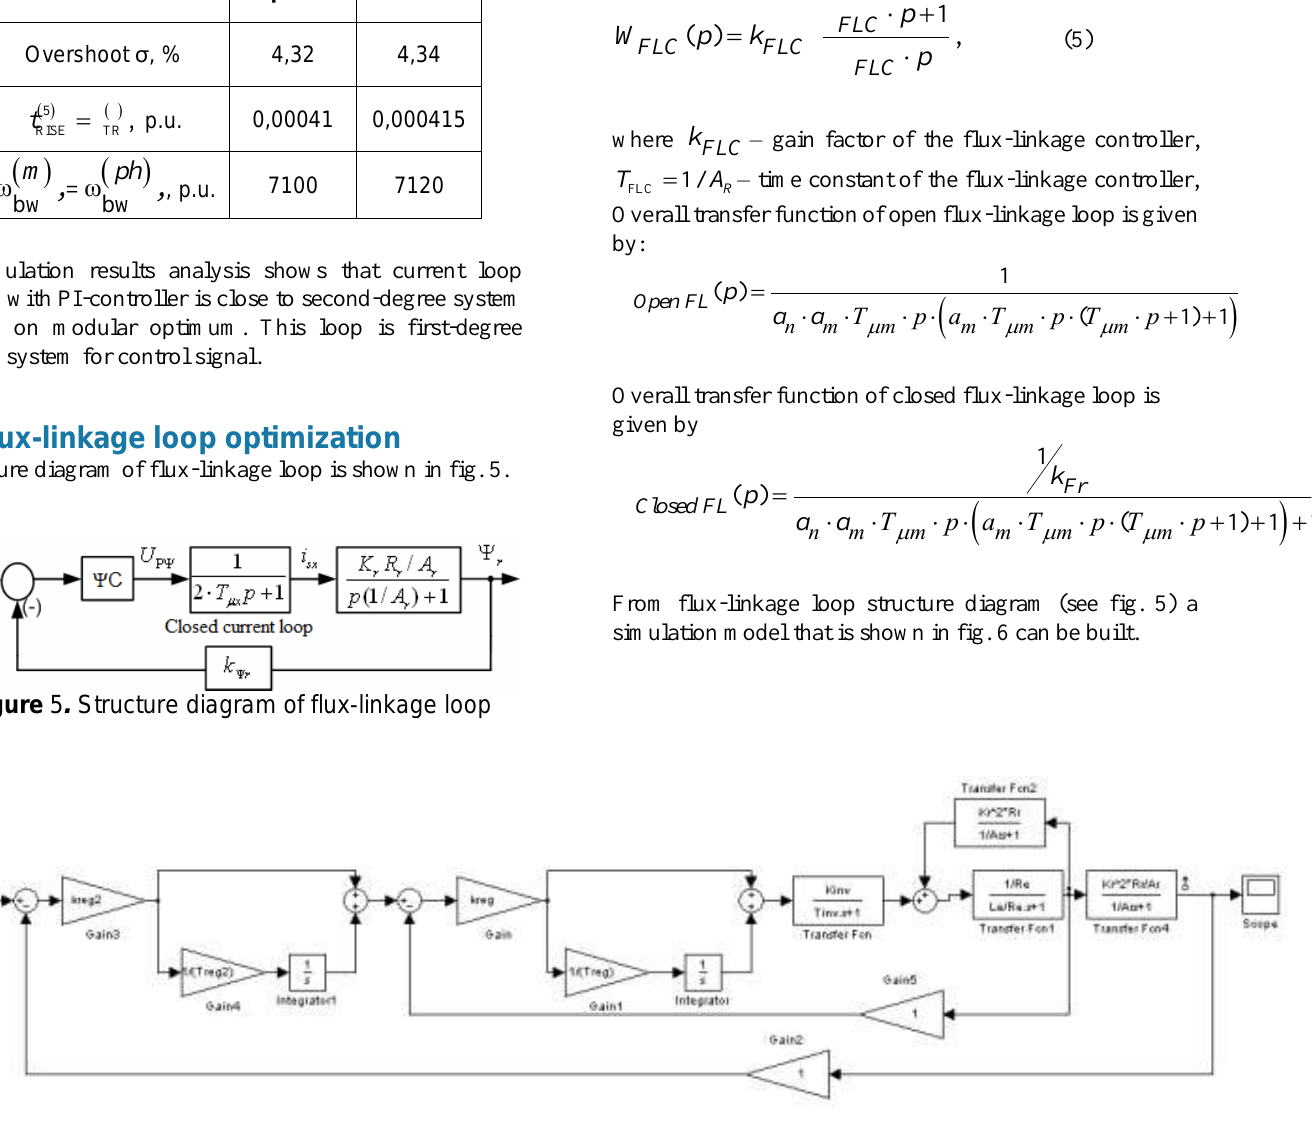
Figure 6. Flux-linkage loop simulation